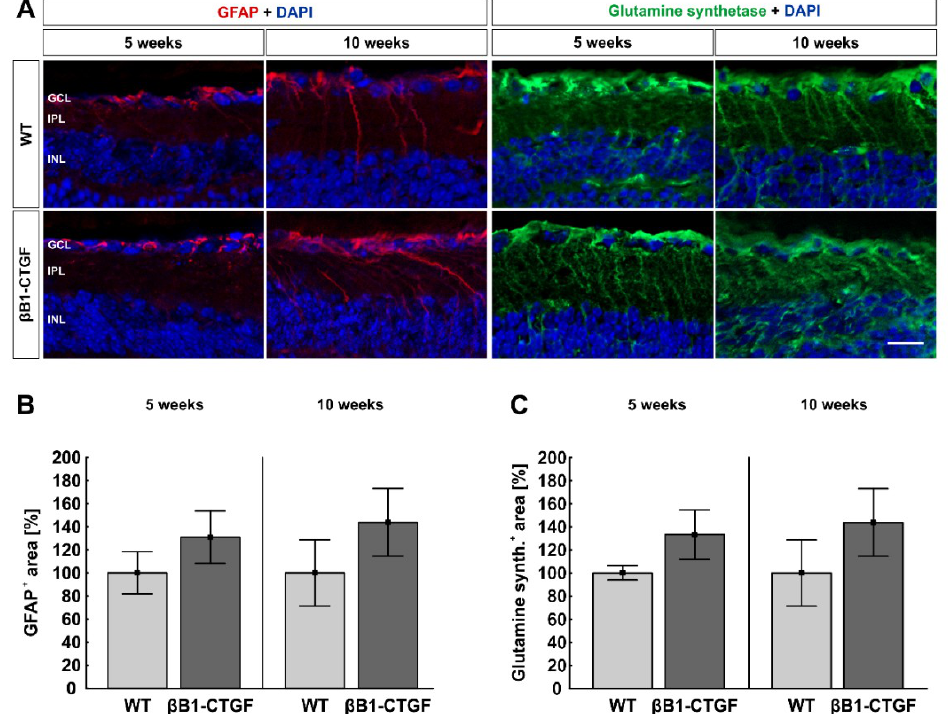
Figure 6: No macroglia reaction. ( A ) Macroglia were analyzed using GFAP (red) and glutamine synthetase (green) at 5 and 10 weeks (n = 7–9/group). DAPI (blue) visualized cell nuclei. ( B ) The GFAP area analysis showed a similar GFAP signal area in βB1-CTGF retinae and WT retinae at 5 and 10 weeks. ( C ) Regarding glutamine synthetase, we observed no difference in the staining area in βB1-CTGF mice compared to in WT at both ages. Abbreviations: GCL = ganglion cell layer, IPL = inner plexiform layer, INL = inner nuclear layer. Values are mean ± SEM. Scale bar: 20 µm.